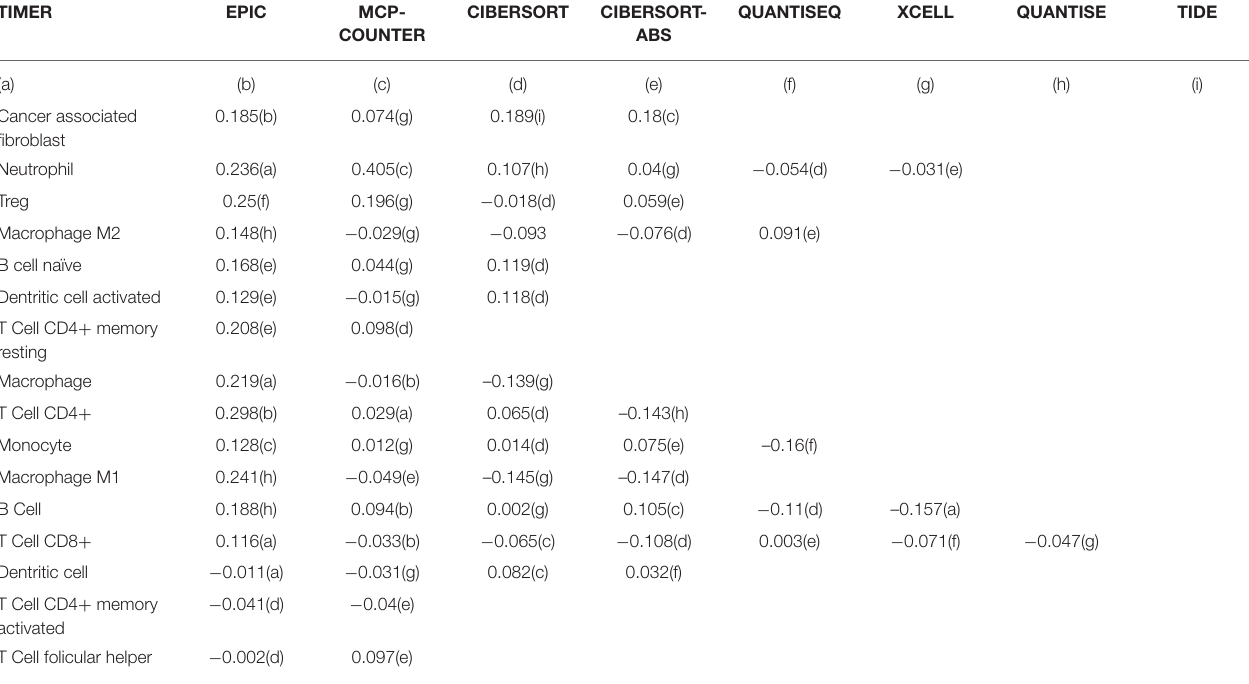
TABLE 3 | PER1 expression and infiltration levels of immune cells.